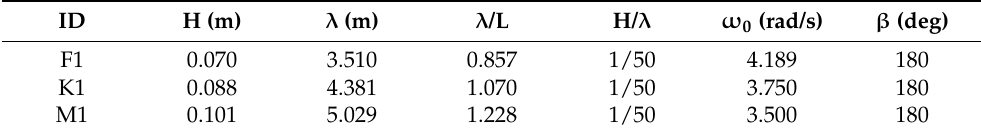
Table 6. Wave parameter information for F1, K1, and